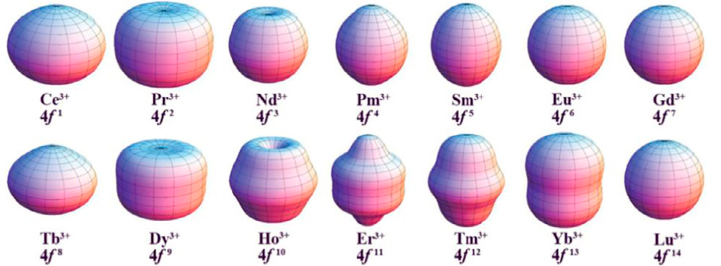
Figure 1. Electrostatic potential surfaces corresponding to the eigen states with different M J values for each Ln(III) ion. In the absence of a crystal-field all the eigen states with different M J values are degenerate for a particular Ln(III) ion. The shapes are evaluated with respect to the local reference frame for the electrostatic potential surfaces corresponding to the eigen states with the maximum M J values. The figure and caption are reproduced from Reference [23] with permission from the Royal Society of